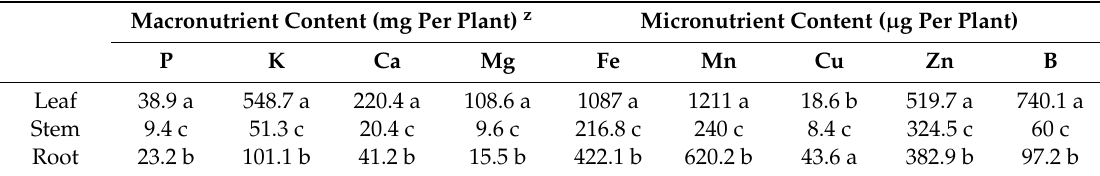
Table 4. Allocation of macro- and micro-nutrient contents among leaves, stems, and roots within H. macrophylla ‘Merritt’s